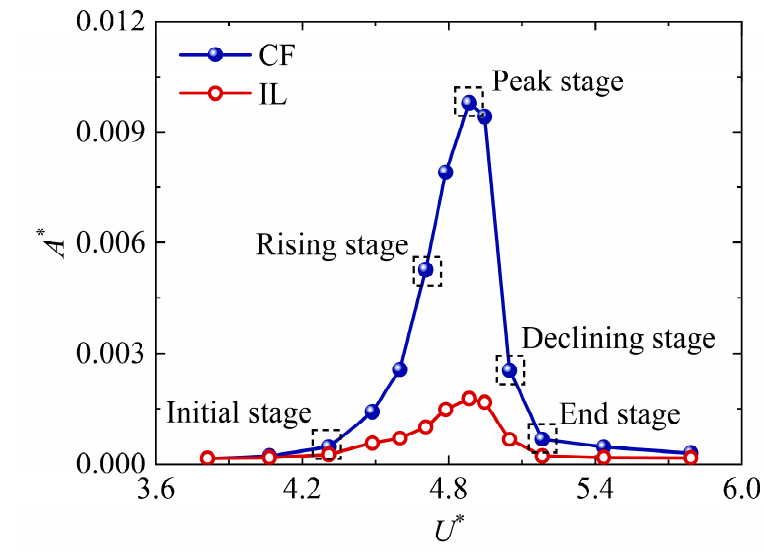
Figure 5. Variation in dimensionless amplitude with reduced velocity.